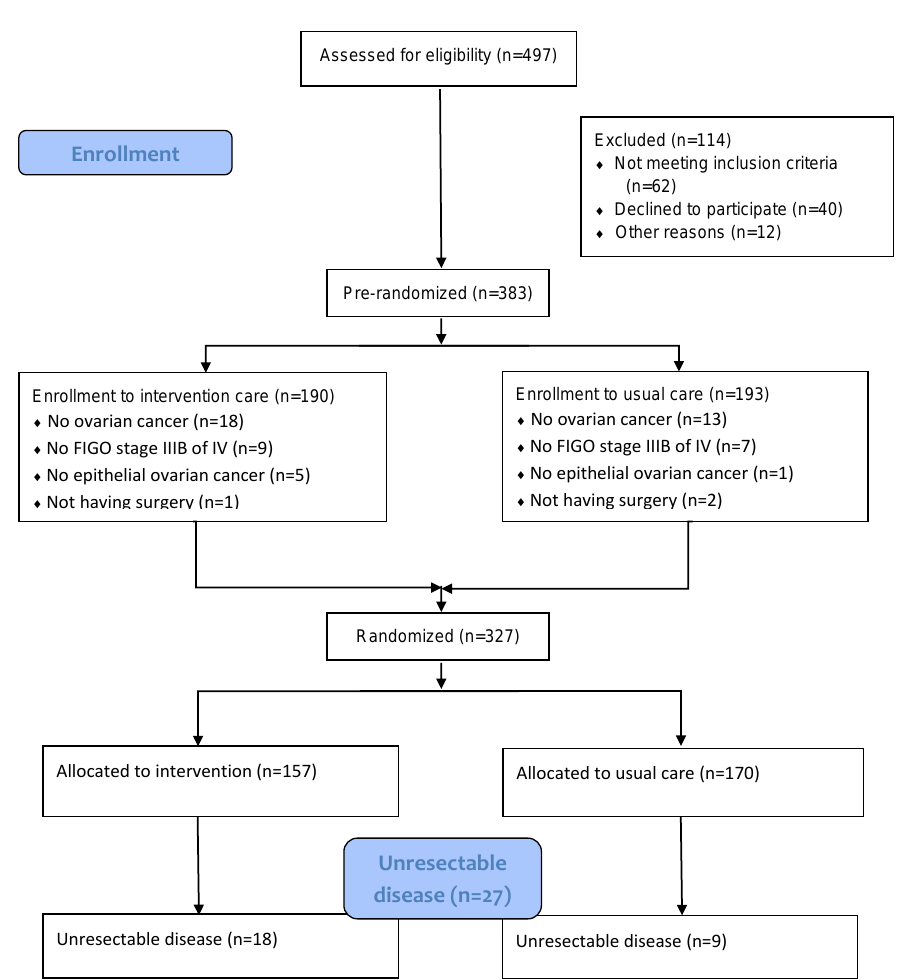
Figure 1. Consort flow diagram PlaComOv study.